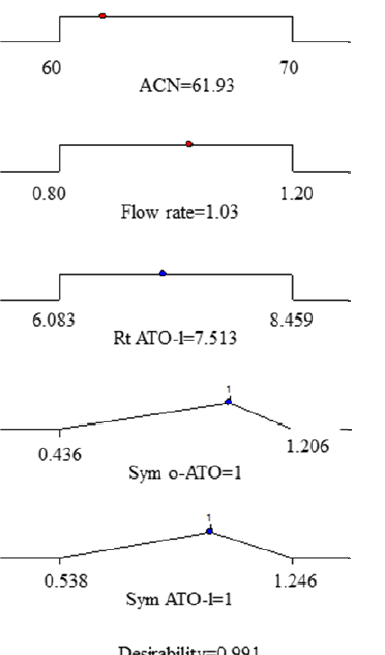
Figure 2. Bar graph showing individual desirability values ( d